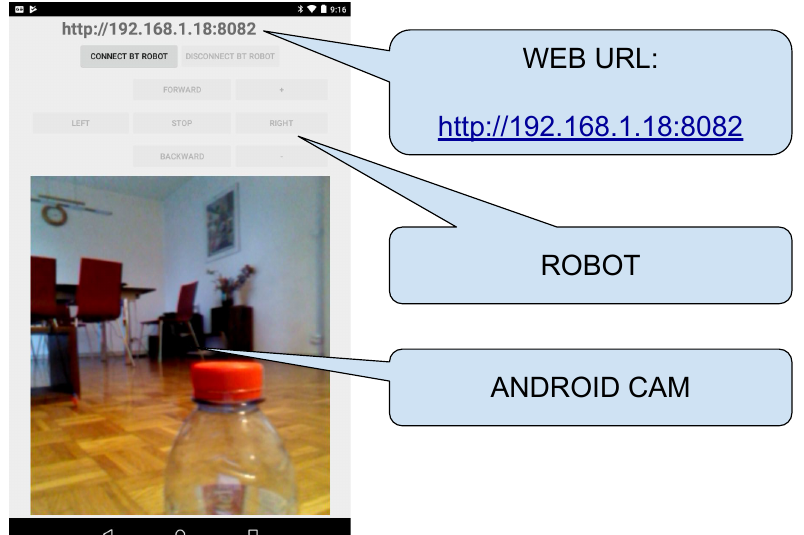
Figure 19. Android Application designed by engineering students, visualizing the mobile phone camera preview, buttons to control the robot via bluetooth, and showing the URL to let a web browser connect to this application and control the robot via web.